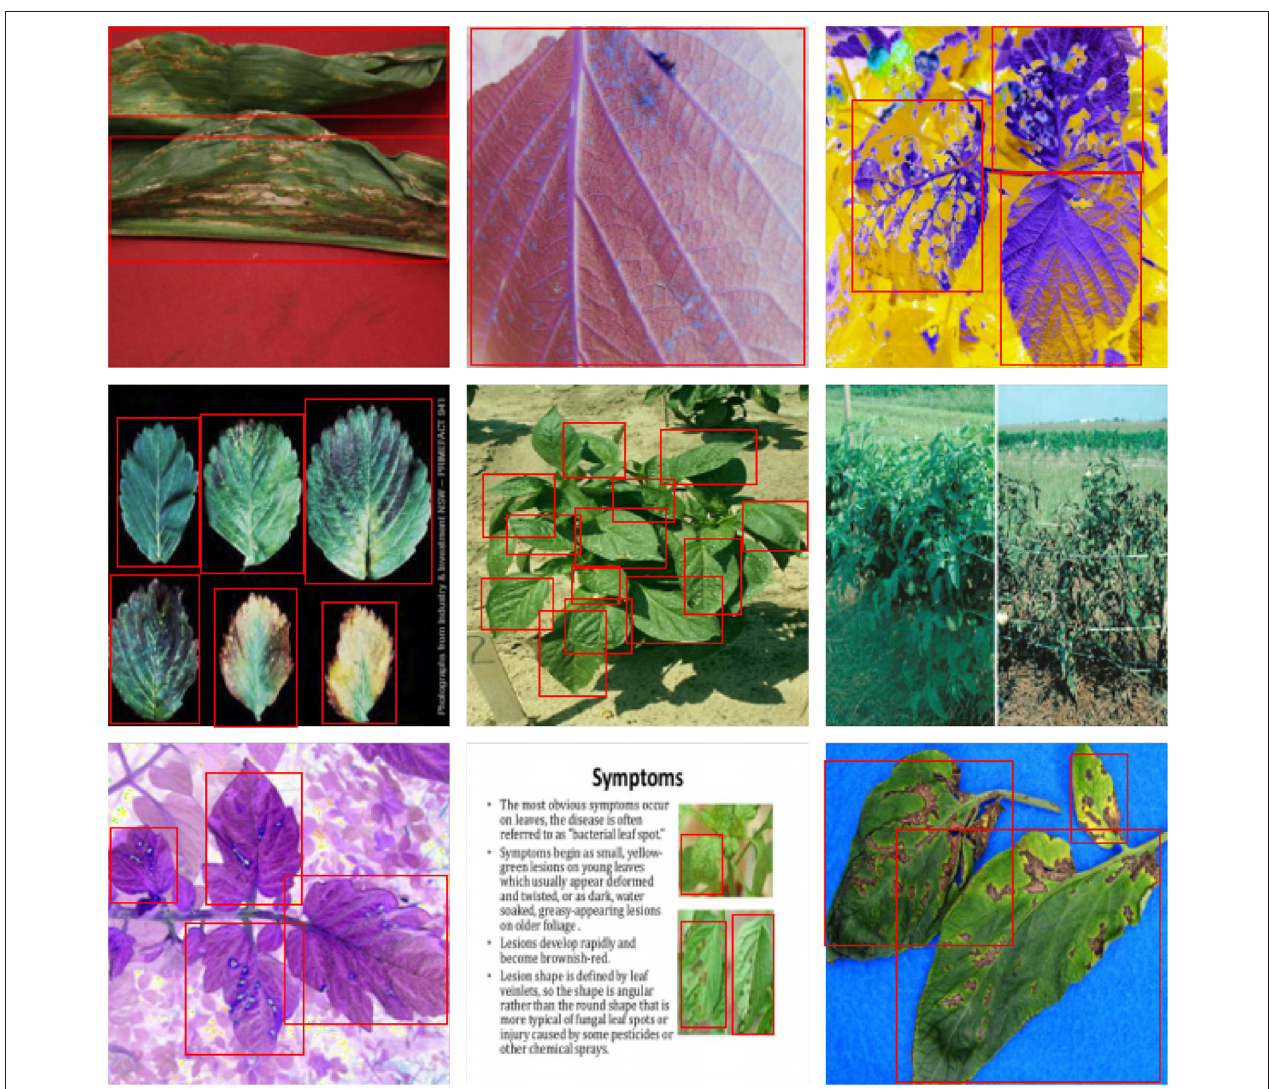
FIGURE 9 | The detection results of EfficientDet L2 in the